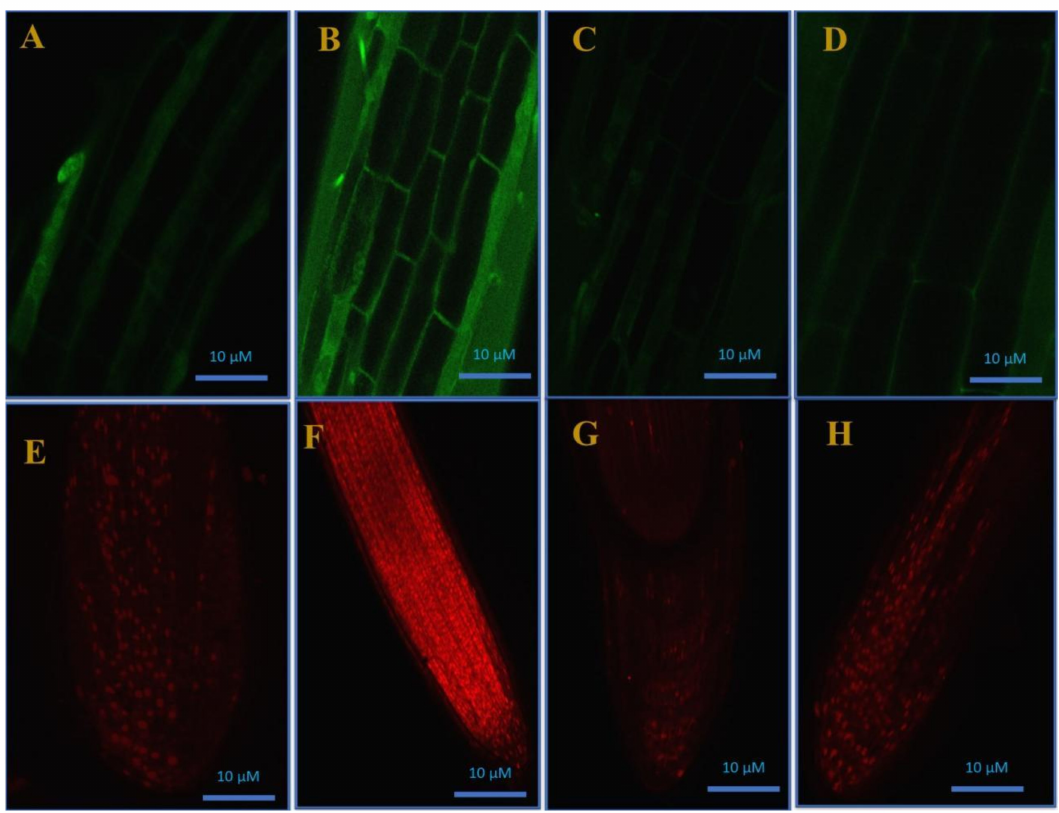
Figure 5. Confocal microscopic images of H 2 O 2 formation in roots using H 2 DCFDA staining ( A – D ) and cell viability test ( E – H ) by propidium iodide staining in roots of mustard ( Brassica juncea cv. Giriraj) in control ( A , E ), in 200 mg Cd kg − 1 soil ( B , F ), in 100 µ M of SNP (NO donor) + 200 mg S kg − 1 soil of elemental sulfur (ES) in presence of Cd ( C , G ), and in 100 µ M SNP + 200 mg S kg − 1 soil of ammonium sulfate (AS) in presence of Cd ( D , H ) at 30 days after sowing. C, control; Cd, cadmium; cv., cultivar; H 2 DCFDA, 2’,7’-dichlorodihydrofluorescein diacetate; SNP, sodium nitroprusside. Table 6. Effect of 100 µ M SNP (NO donor) and 200 mg S kg − 1 soil of elemental sulfur (ES) or ammonium sulfate (AS) in the presence or absence of 200 mg Cd kg − 1 soil on NO content, H 2 S content, and L-DES activity in mustard ( Brassica juncea L. cv. Giriraj) at 30 days after sowing. Data are presented as treatment mean ± SE (n = 4). Data followed by the same letter are not significantly different as determined by LSD test at p ≤ 0.05. Cd, cadmium; FW, fresh weight; H 2 S, hydrogen sulfide; L-DES, L-cysteine dedulfhydrase; NO, nitric oxide; SNP, sodium nitroprusside.